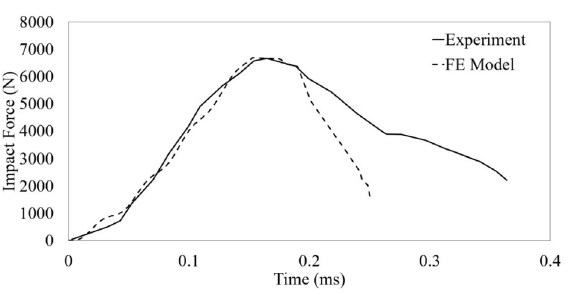
Figure 5. Time histories of impact force obtained by this study in comparison with the one performed by Carney et al. 25